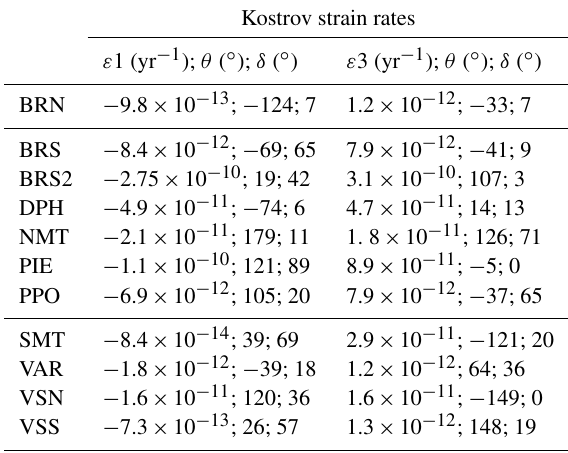
Table 1. Strain tensors (Kostrov’s method) for each of the 11 sub- areas. Strain rates display the first ( ε 1) and third ( ε 3) eigenvalues of the strain tensor, corresponding to compression and extension, respectively, as well as their azimuth ( θ , in degrees from north) and dip ( δ , degrees) used to project the strain tensors at the surface in Fig.